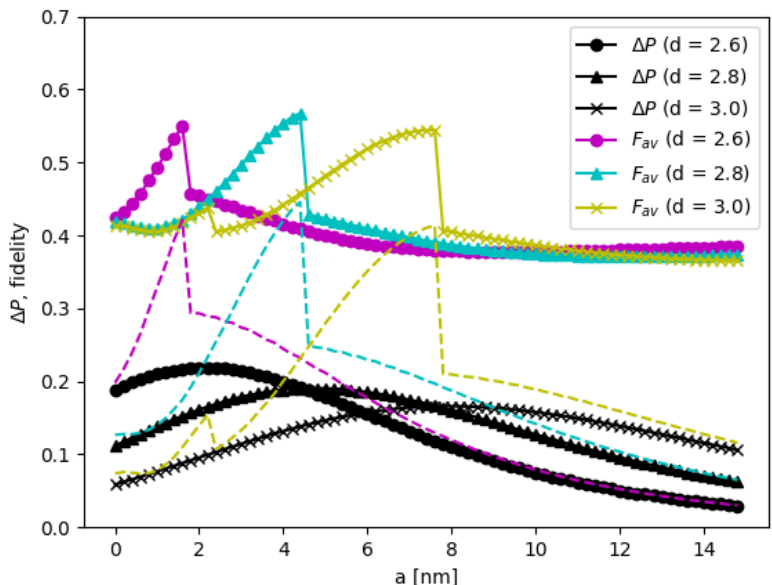
Figure 15. CNOT gate efficiency with the average fidelity F av and ∆ P as a function of the inter-DQD distance a . The DQD potential is MoS 2 , and the QD base length b = 2.2 nm. The inter-QD distance d is depicted by different